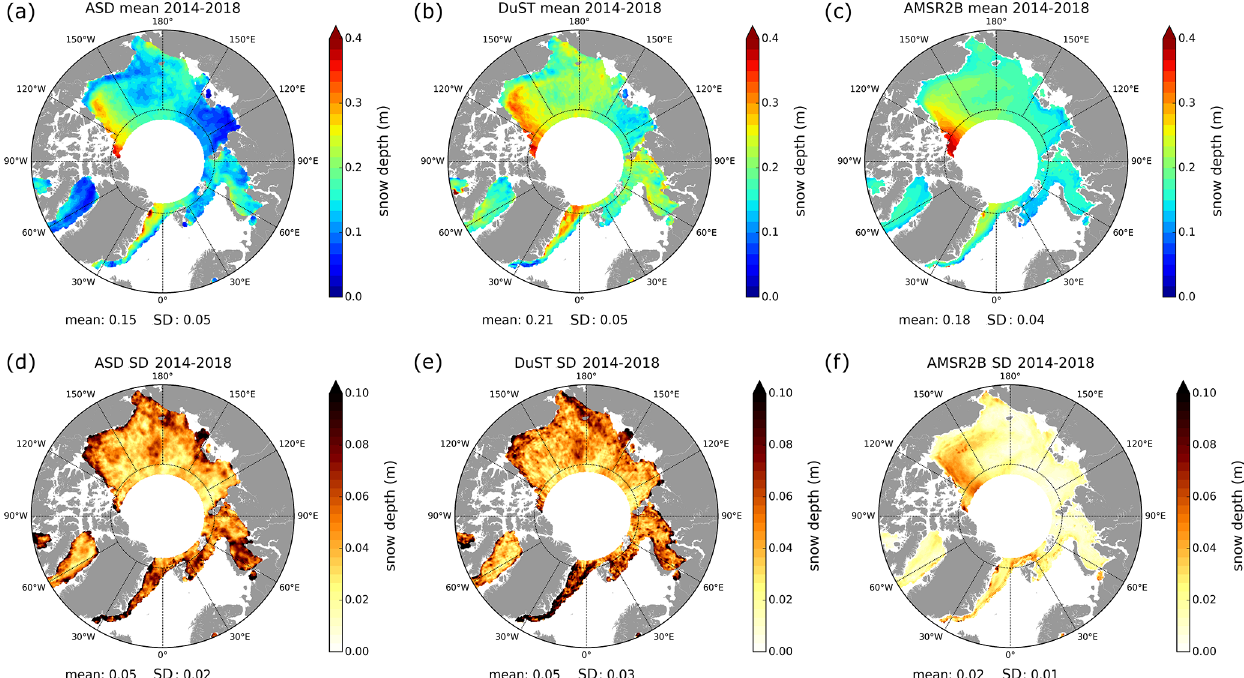
Figure 3. Comparisons of satellite snow depth estimations in the Arctic. (a, b, c) Bi-monthly March and April “climatological” snow depth mean maps calculated over the period 2014–2018 for the ASD data (a, d) , the DuST data (b, e) and the AMSR2B data (c, f) . (d, e, f) The standard deviation between all the data used to calculate the mean snow depth maps (equivalent to the mean interannual variability computed with March and April over the same 2014–2018 time